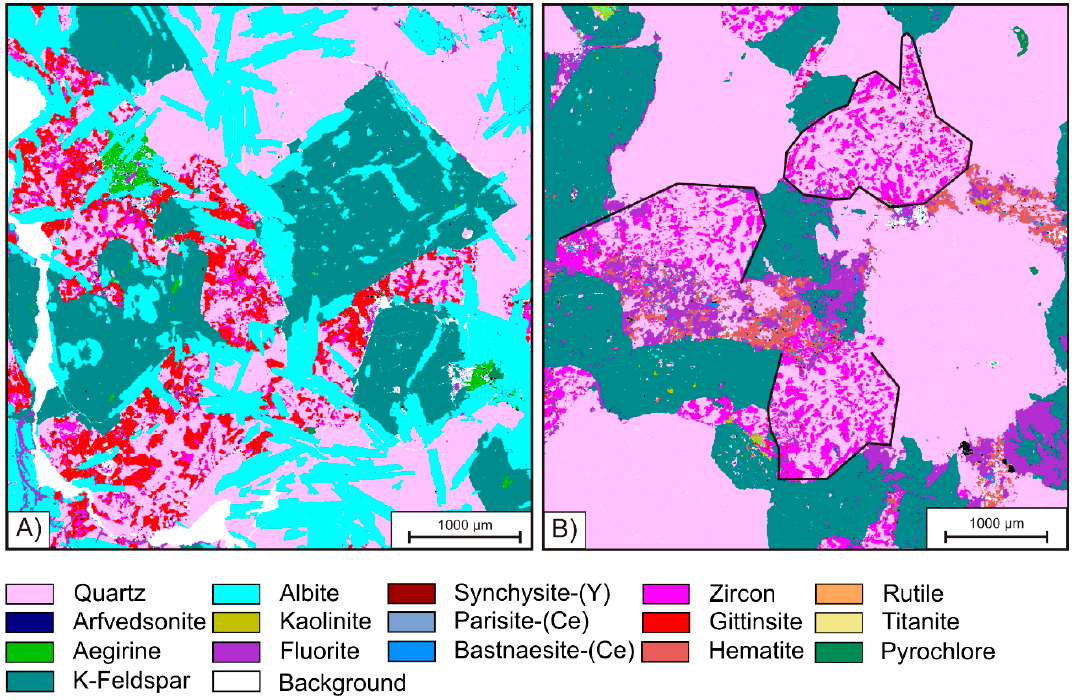
Figure 4. Representative QEMSCAN © phase maps of Zr-REE-Nb ore. ( A ) Zircon-gittinsite cluster in sample KB G1. The core of a residual aegirine (green) is recognizable within the cluster. ( B ) Zircon-quartz cluster containing fluorite (purple) and hematite (pale red) in sample KB G6. Lines indicate the preserved subhedral shape of precursor amphibole as straight grain boundaries to K-feldspar and coarse grained quartz.